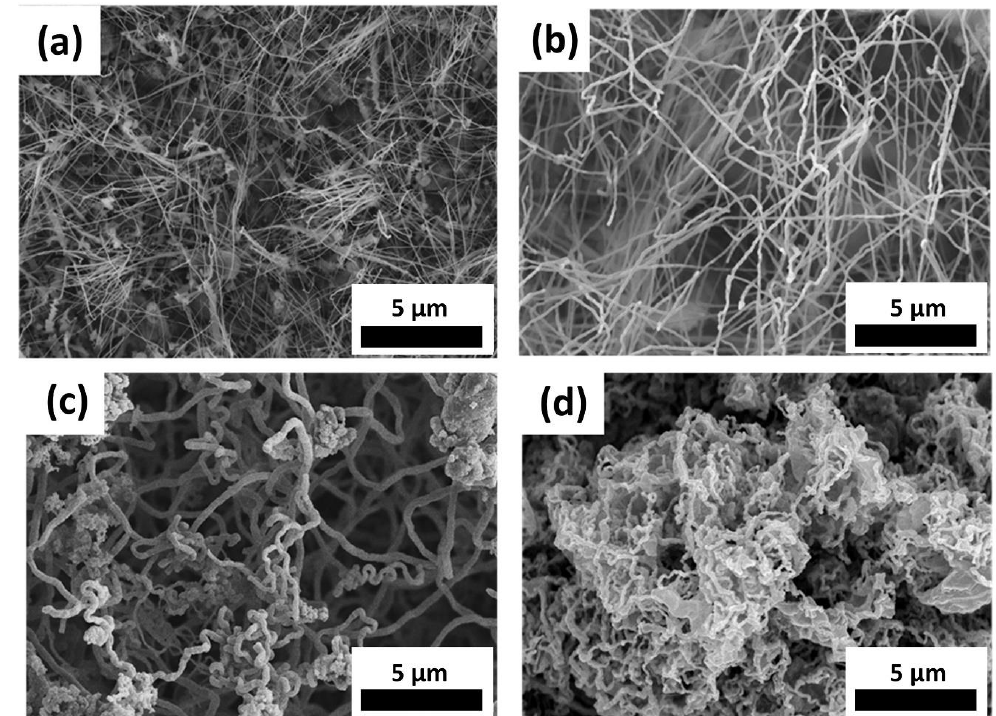
Materials 2018 , 11 , x FOR PEER REVIEW Figure 3. SEM images of samples grown at: ( a ) 3 × 10 −1 torr, ( b ) 2 torr, ( c ) 50 torr, and ( d ) 100 torr. Figure 3. SEM images of samples grown at: ( a ) 3 × 10 − 1 torr, ( b ) 2 torr, ( c ) 50 torr, and ( d ) 100 torr.